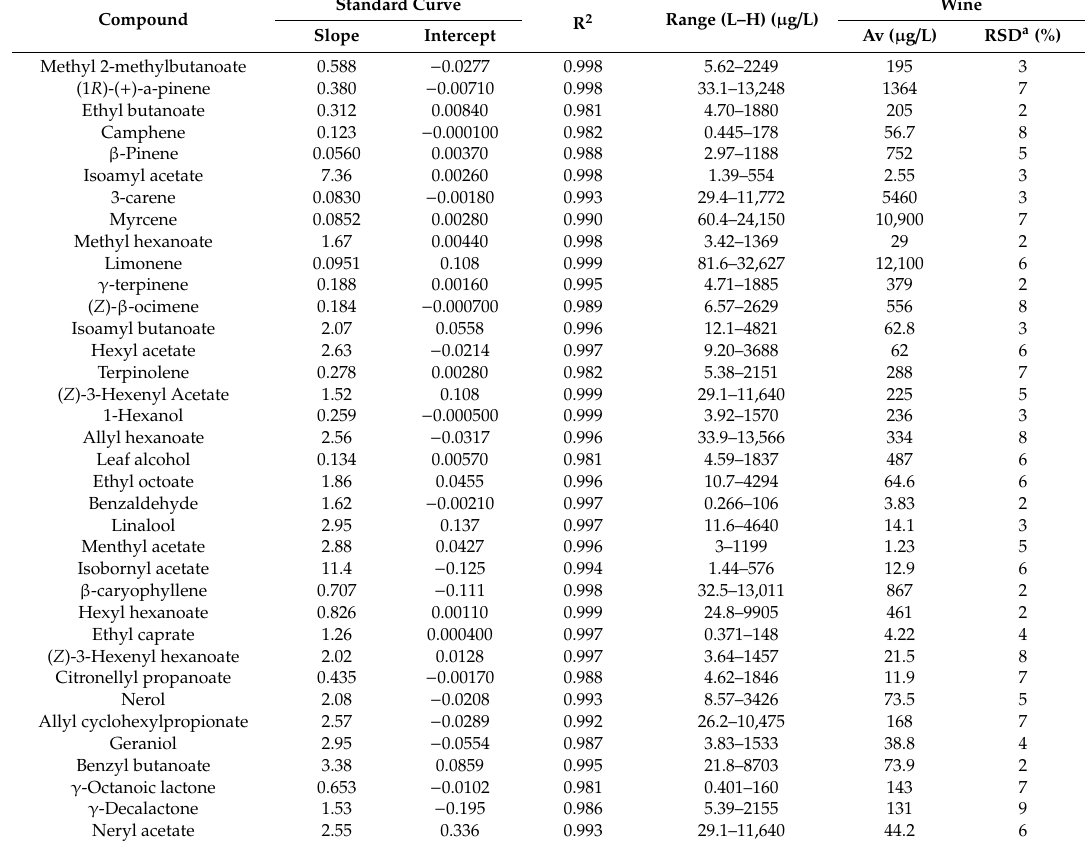
Table 2. Standard curves and concentrations of 36 odorants in mango and vodka cocktail by HS / SPME-GC-MS.